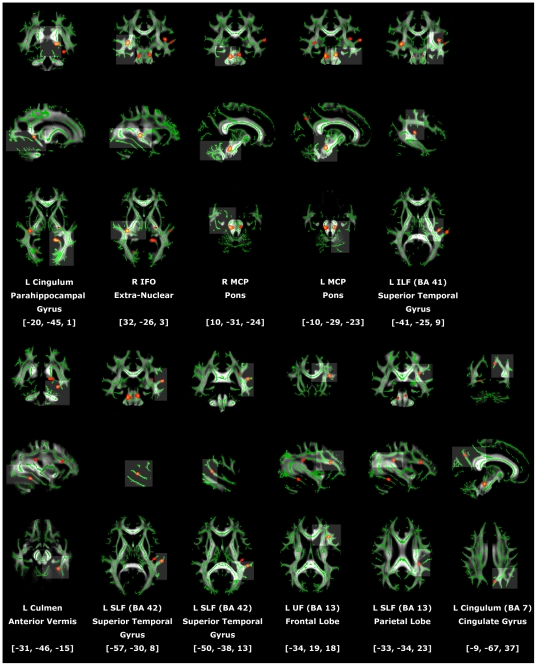
Regions with significantly lower fractional anisotropy (FA) in MMT vs. NC.All reported brain images were acquired using the “tbss_fill” script from the FSL package. The mean group FA skeleton (green) was overlaid on the mean_whole_group_FA images in axial, sagittal, and coronal views. The threshold of the mean FA skeleton was set at 0.2. Regions with significantly lower FA in MMT vs. NC were highlighted on the mean FA skeleton in colored voxels (scale range, from red to yellow). The resulting statistical maps were calculated and corrected for multiple comparisons with cluster-forming threshold t>3 and cluster-wise significance level corrected p<0.05. BA, Brodmann area; IFO, inferior fronto-occipital fasciculus; ILF, inferior longitudinal fasciculus; L, left; MCP, middle cerebellar peduncle; R, right; SLF, superior longitudinal fasciculus; UF, uncinate fasciculus.